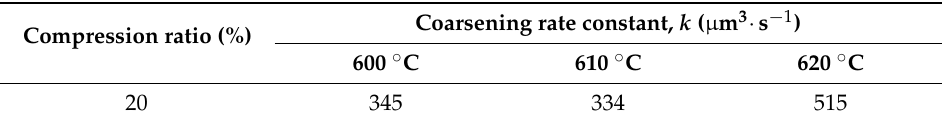
Figure 13. Variations of the cube of average globule size versus isothermal holding time of compressed samples at heating temperatures of 600–620 ˝ C where R 2 is the regression coefficient. Values of coarsening rate constants of compressed samples at various isothermal holding